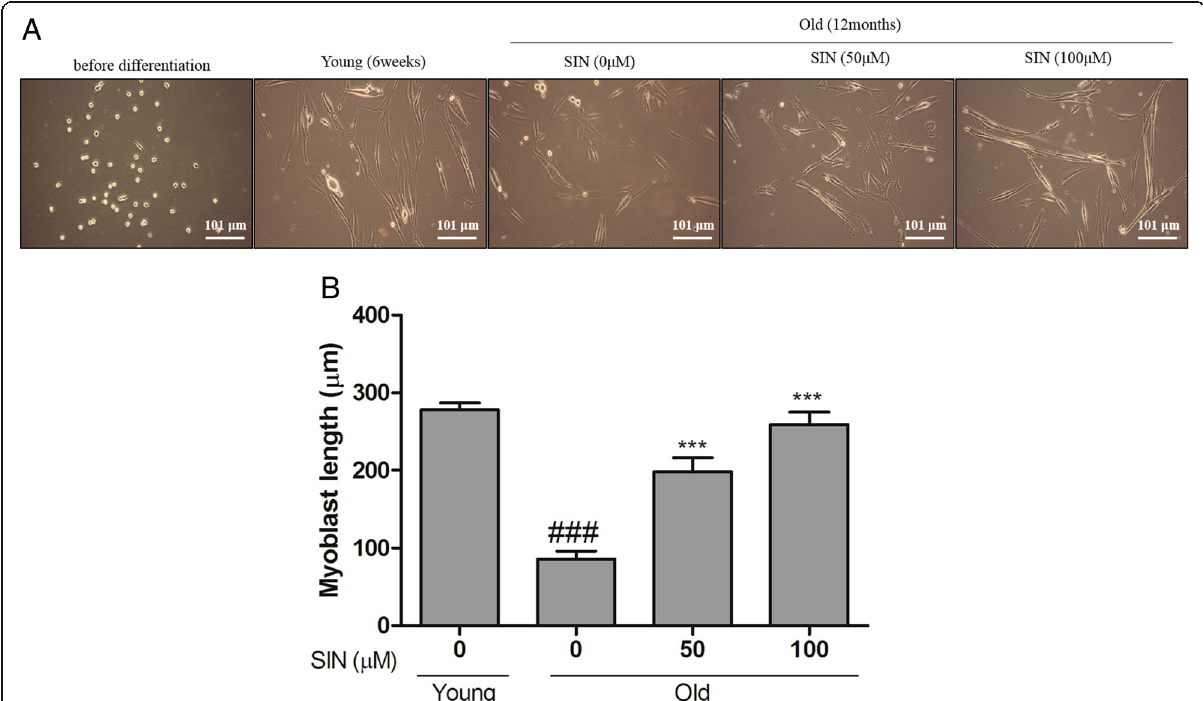
Fig. 2 Morphology changes of isolated satellite cells. Isolated satellite cells were cultured in proliferation medium for 5 days. Differentiation medium was then provided to both young and old groups. Old group cells were treated with sinensetin (SIN) at indicated concentrations in differentiation medium. a Morphological changes of satellite cells were observed after 5 days of treatment with SIN at indicated concentrations (50 and 100 μ M). The observation was done using a light phase-contrast microscope (X200). b Myoblast length was measured using Image J software (U.S. National Institutes of Health, Bethesda, MD, USA). Data are expressed in graphical representation with improved length at indicated concentrations of SIN. Data in graphs are presented as mean ± SEM. Statically significance was determined with ANOVA followed by a Dunnett ’ s test; ### p < 0.05 vs. young, *** p < 0.05 vs. old with no